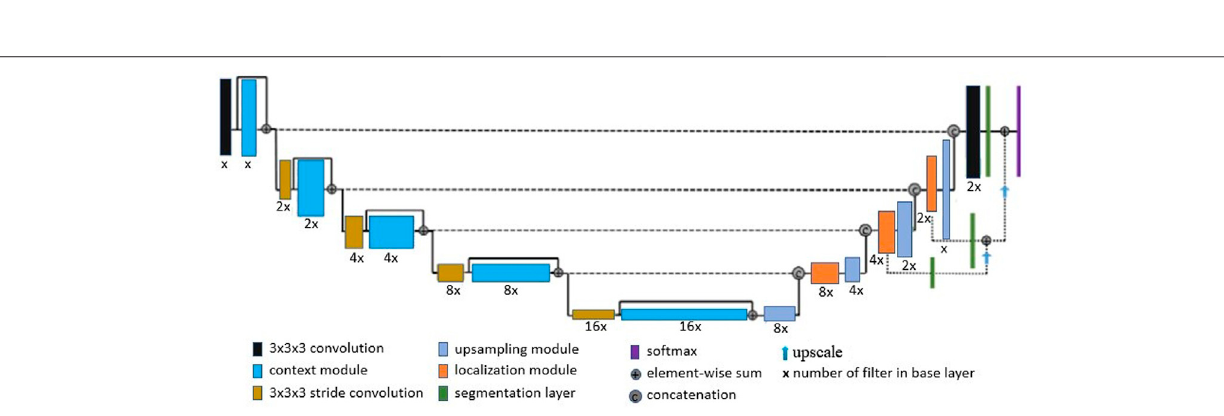
FIGURE 4 | Network Architecture: We derived our network architecture from the work proposed by Isensee et al. (2017), in which 16 base layer fi lters and a depth of 5 were used. We treated both network depth and number of fi lters in the base layer as hyperparameters, which were determined by a Bayesian optimization and grid